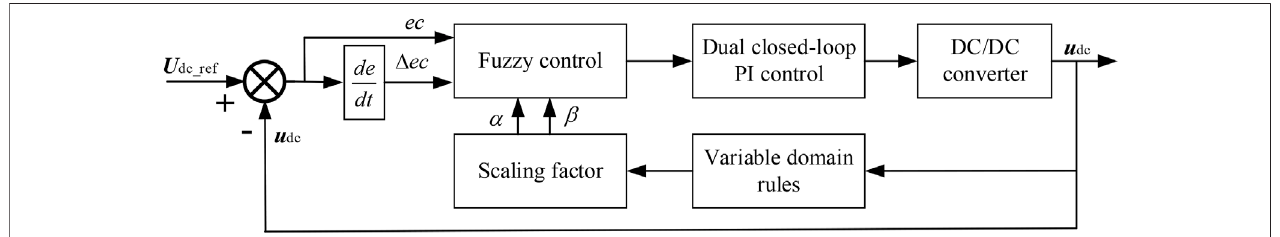
FIGURE 3 | Variable domain fuzzy-logic control for DC-DC